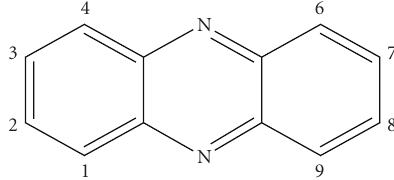
Figure 1: The numbering of the C-atoms.